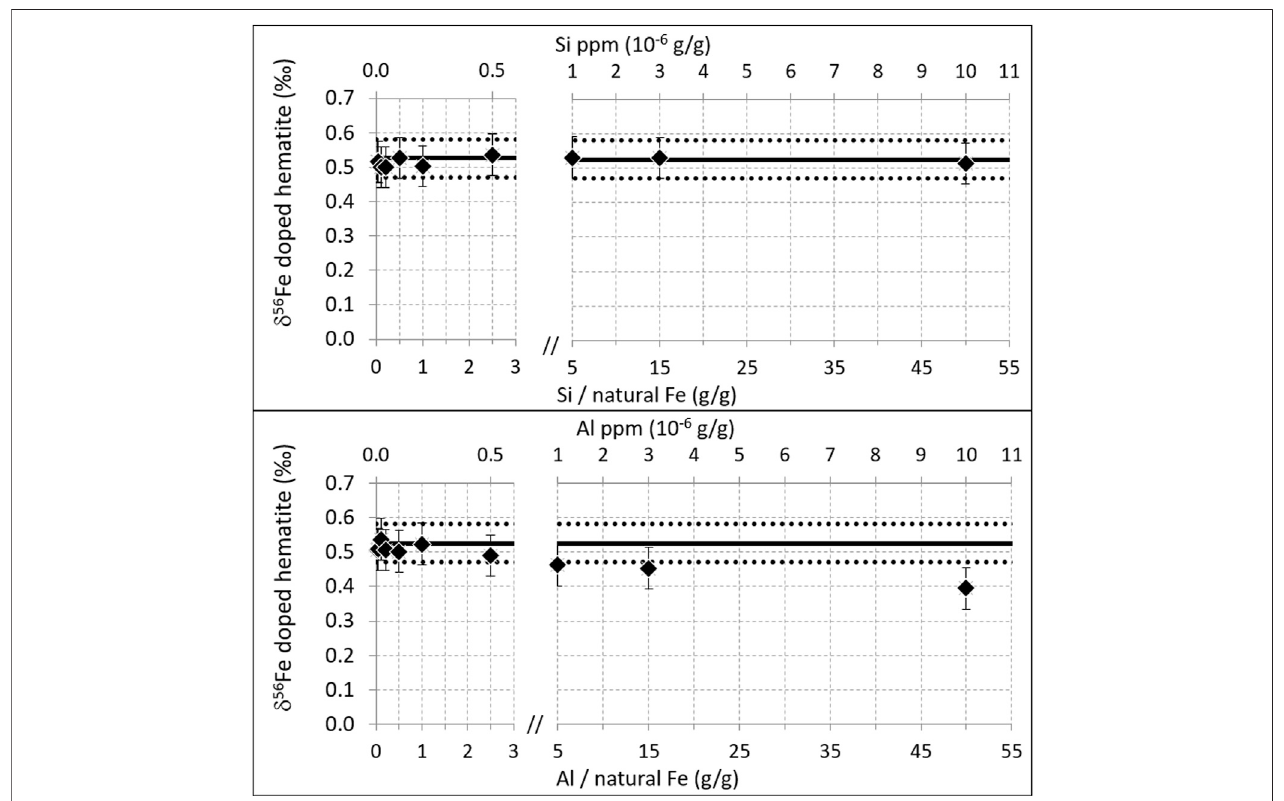
FIGURE 7 | Same as Figure 4 , for Al and Si. Measurements performed on the Neptune Plus, in October 2018. Resolution 13,000, plateau 270 ppm, natural Fe concentration 200 ppb.